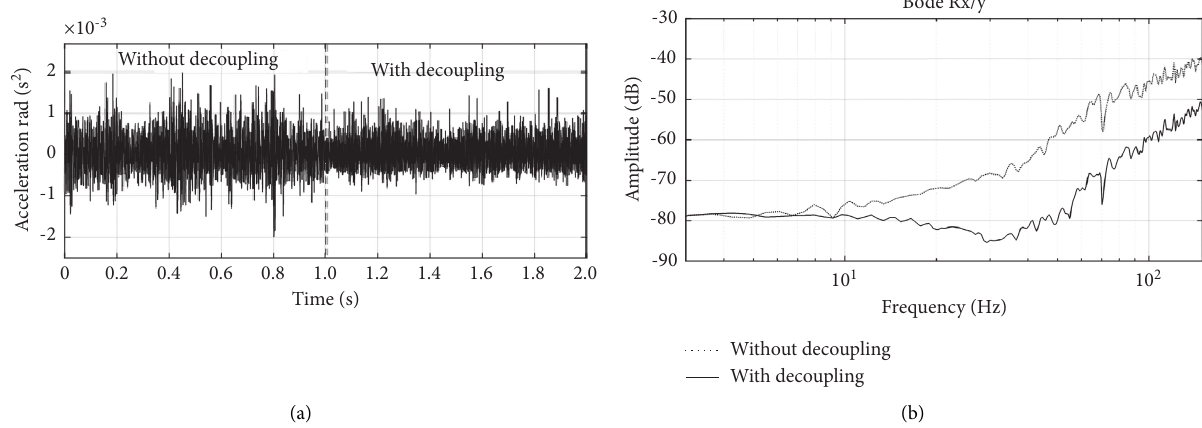
Figure 7: Comparison of random signal before and after decoupling without load. (a) Acceleration and (b) frequency domain waveform.